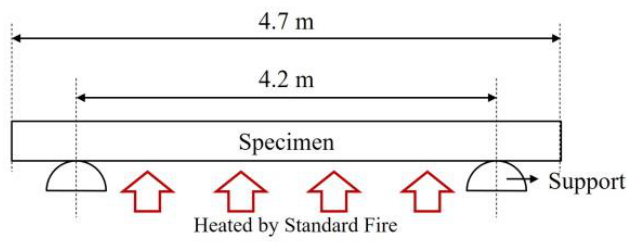
Figure 7. Floor specification for fire tests based on revised version (2019) of Korean Standards [12,13].